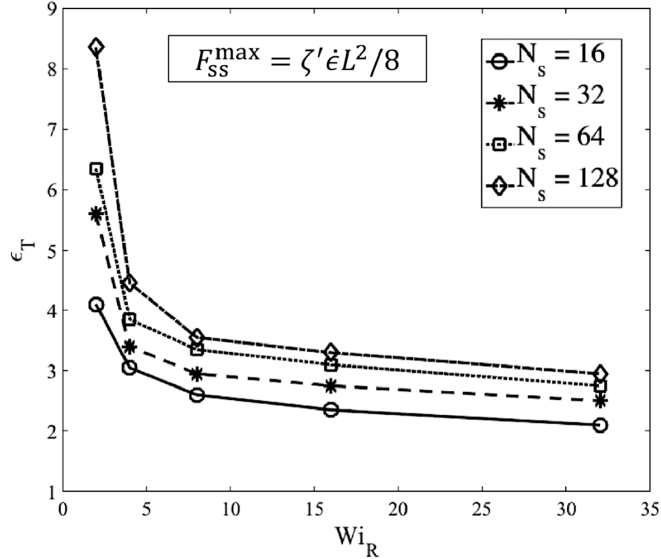
Figure 13. Transition strain for different chain lengths as a function of Rouse Weissenberg number for slip-spring simulations under MEF assumption.